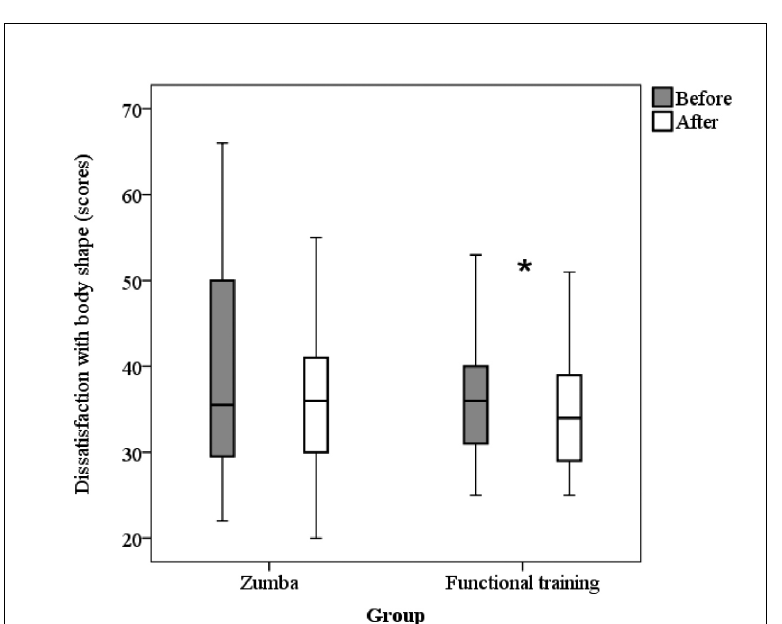
Figure 2. Changes in dissatisfaction with body shape after Zumba and functional training